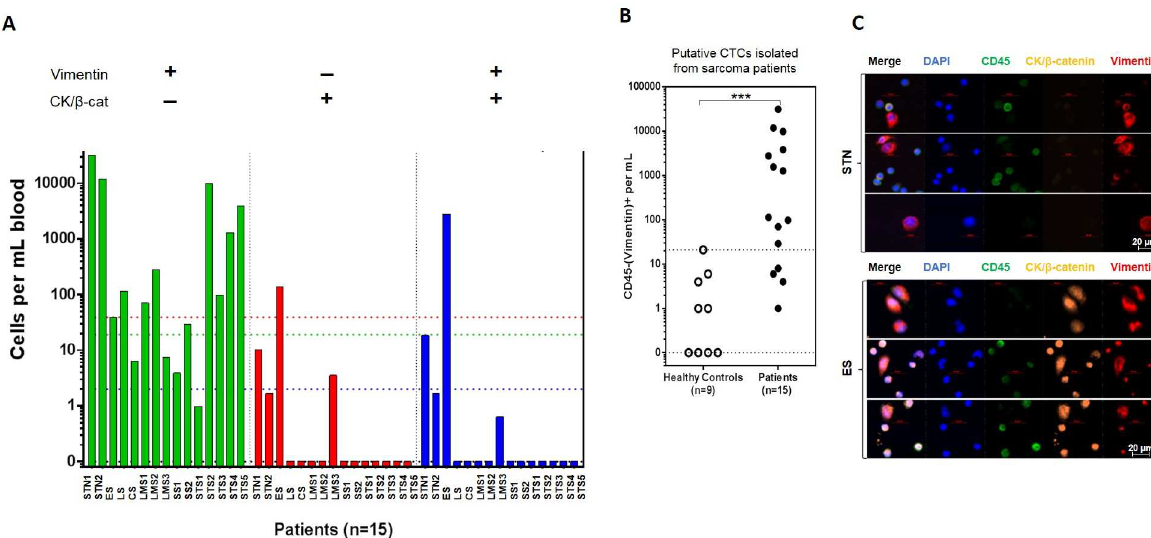
Fig 3. Enumeration and phenotypic characterization of CTCs from patients with sarcoma. Blood from advancedsarcoma patients and healthydonors were processedusing the ApoStream ® device. Healthy donors(n = 9, open circles) were used to demonstrate assay specificity. (A) In 4 of the 15 sarcoma patients, phenotypicheterogeneity was seen. Coloreddotted lines correspond to the assay cut-off for each of the phenotype measured. STN, soft tissue neoplasm; ES, embryonal cell sarcoma; LS, liposarcoma; CS, chondrosarcoma; LMS, leiomyosarcoma; SS, synovialsarcoma; STS, soft tissue sarcoma. (B) The advancedsarcoma patients (n = 15, closed circles) had significantly highernumbers of cells with CD45 - /VIM + phenotype ( p = 0.0002),with 73% of patient samples abovethe 21 cells/mL cut-off. (C) Gallery of CTCs from a patient with soft tissue neoplasm(STN; top) and a patient with embryonal cell sarcoma (ES; bottom). Putative CTCs isolatedusing ApoStream ® were identifiedusing antibodiesagainstCK/ β -catenin (orange),vimentin (red), and a nuclear stain (DAPI), while excludingleukocytes with marker CD45 (green). Scale bars correspondto 20 μ m.